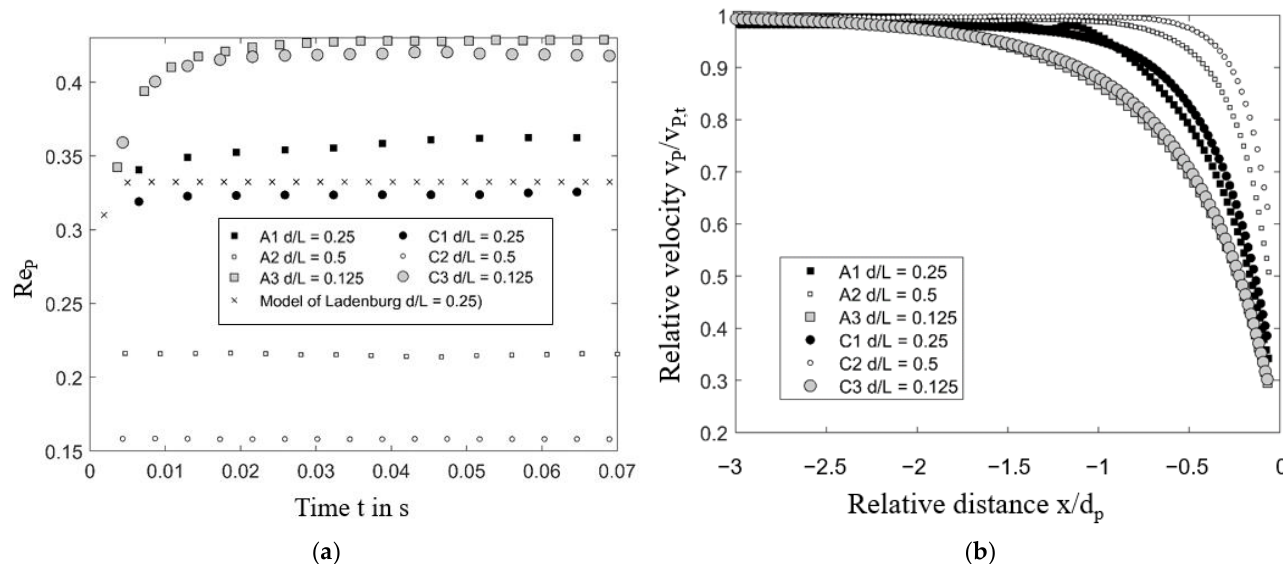
Figure 15. ( a ) Influence of model width on the settling behavior for different models: with periodic boundaries (A1, A2, A3) and solid wall boundaries (C1, C2, C3), as well as theoretical approach according to Ladenburg. ( b ) Ratio of the particle velocity ( v p ) to the maximum velocity (terminal velocity v p,t ) depending on the ratio of the distance to wall x and particle diameter d p .